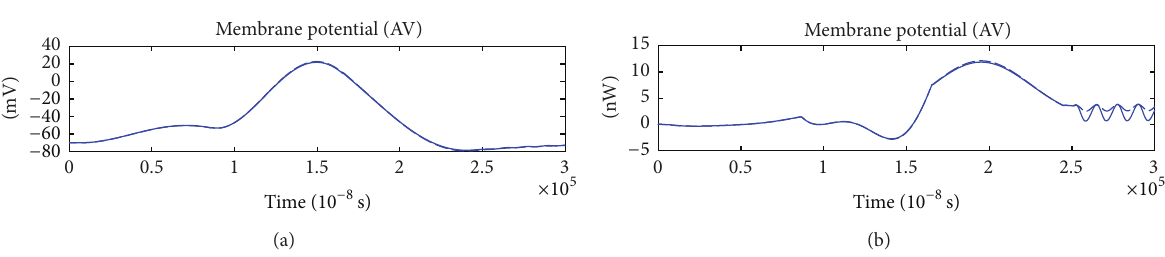
where 𝑄 denotes the synaptic noise as Gaussian white noise with the unit 𝜇